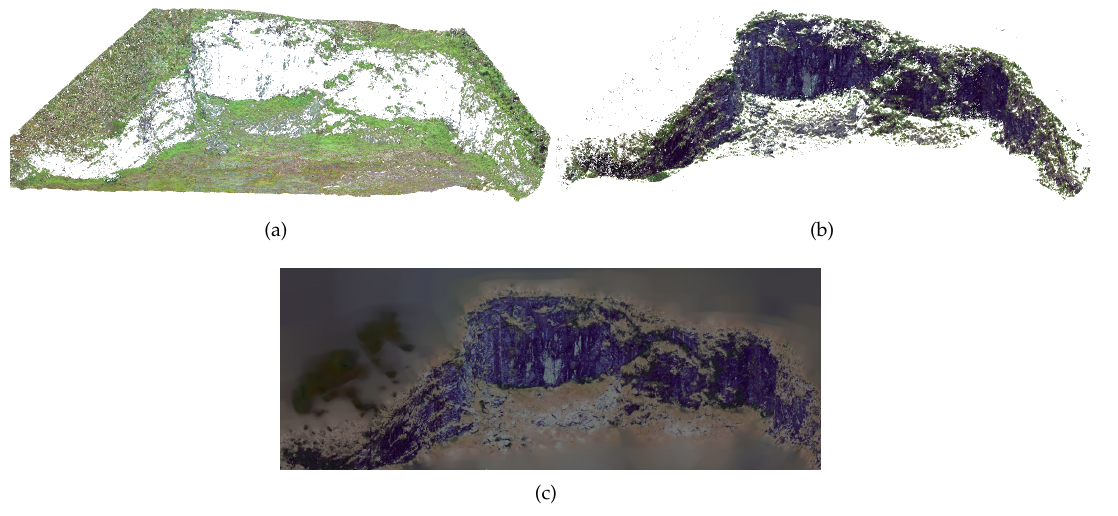
Figure 12. Results of the Algorithm Applied on an Abandoned Gravel Extraction Site. ( a ) Vegetation. ( b ) Underlying soil. ( c ) Poisson Surface